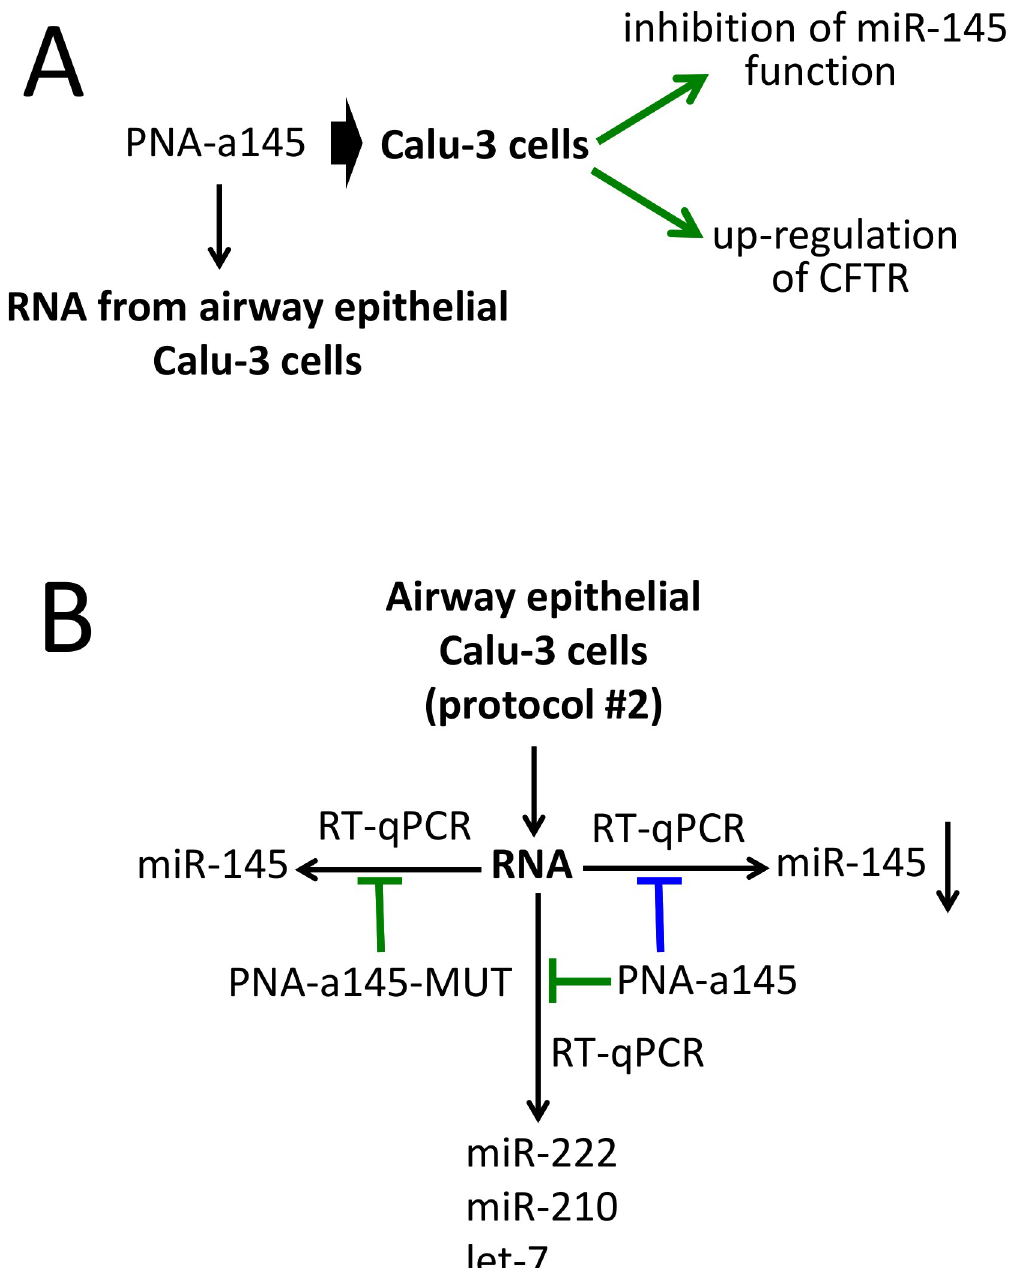
Fig 3. Biological effects of a PNA targeting miR-145-5p and outline of the practical laboratory program. A. Scheme of the background available in the literature on the biological effects of the R8-PNA-a145 on the Calu-3 cell line (Fabbri et al.,